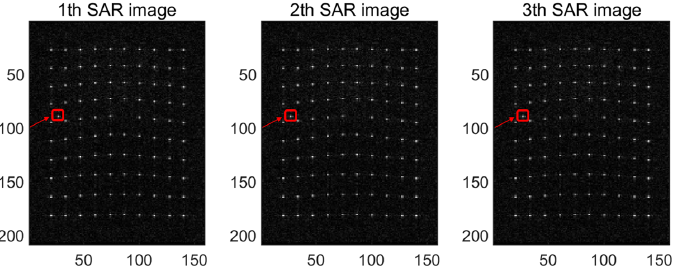
Figure 20. Moving point result ( v x = 0.1 m/s) with baseline number 10: ( a ) 1st point; ( b ) 55th point.